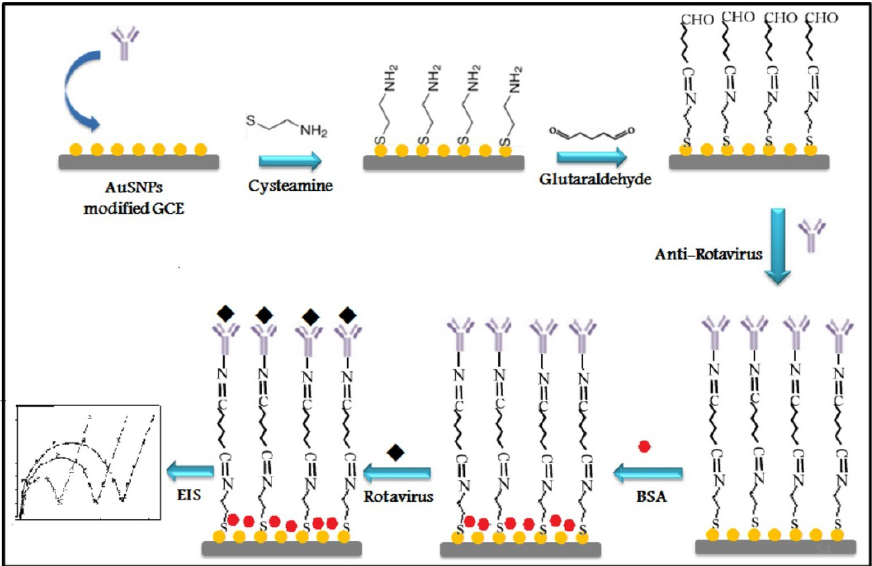
Figure 5. Schematic illustration of the stepwise preparation of anti-rotavirus self-assembled monolayers (SAM) immunosensor (BSA: Bovine Serum Albumin). Reprinted with permission from ref. [74]. Copyright 2016, John Wiley & Sons, Inc.